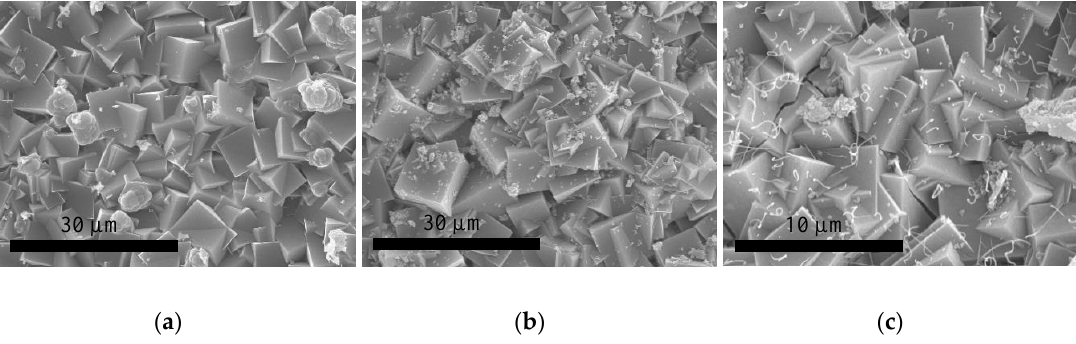
Figure 9. Top view SEM images of ITQ-29 materials grown on the alumina supports after calcination at: ( a ) 773 K; ( b ) 823 K; ( c ) 873 K.